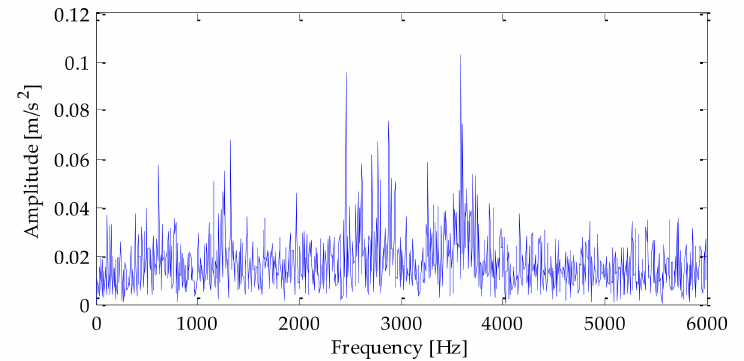
Figure 24. Frequency domain analysis of the mixed signal.